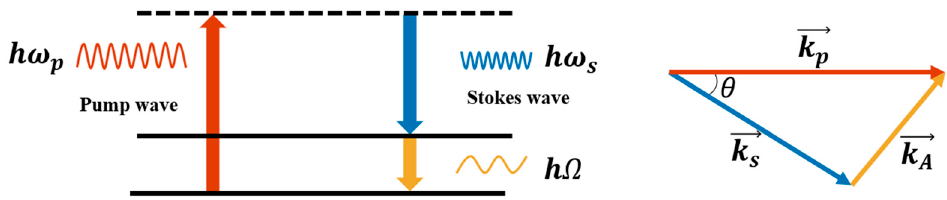
Figure 3. Diagram of Brillouin scattering energy conservation and momentum conservation.